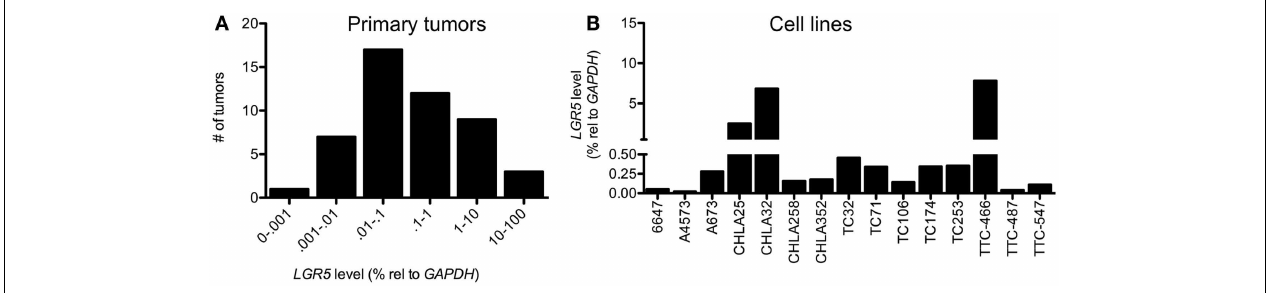
15 ES cell lines. For primary tumors levels of expression relative to GAPDH were < 0.001% in 1 tumor, 0.001–0.01% in 7 tumors, 0.01–0.1% in 17 tumors,